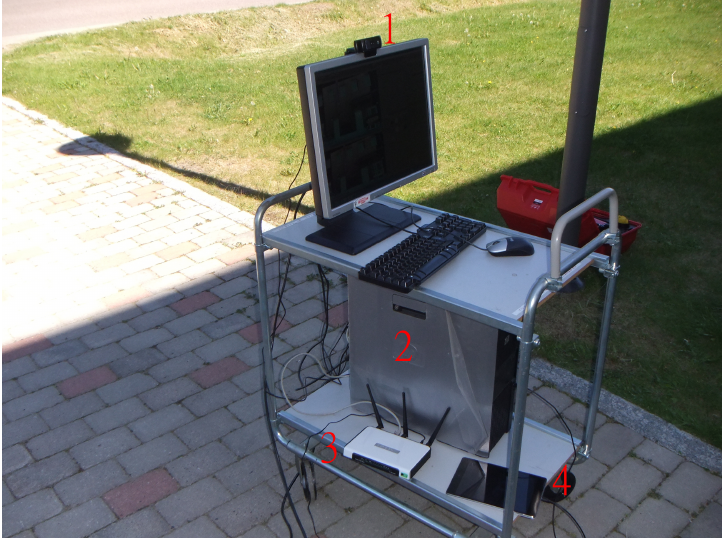
Figure 3. Hardware of the prototype TPP AR system. 1: webcam; 2: desktop computer; 3: wireless router; 4: tablet